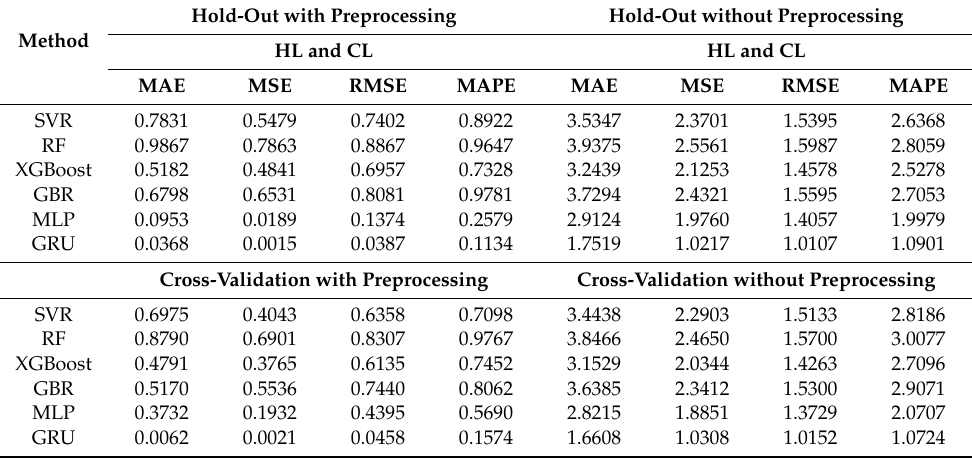
Table 6. Experimental results of various ML and DL models for MO prediction using the hold-out